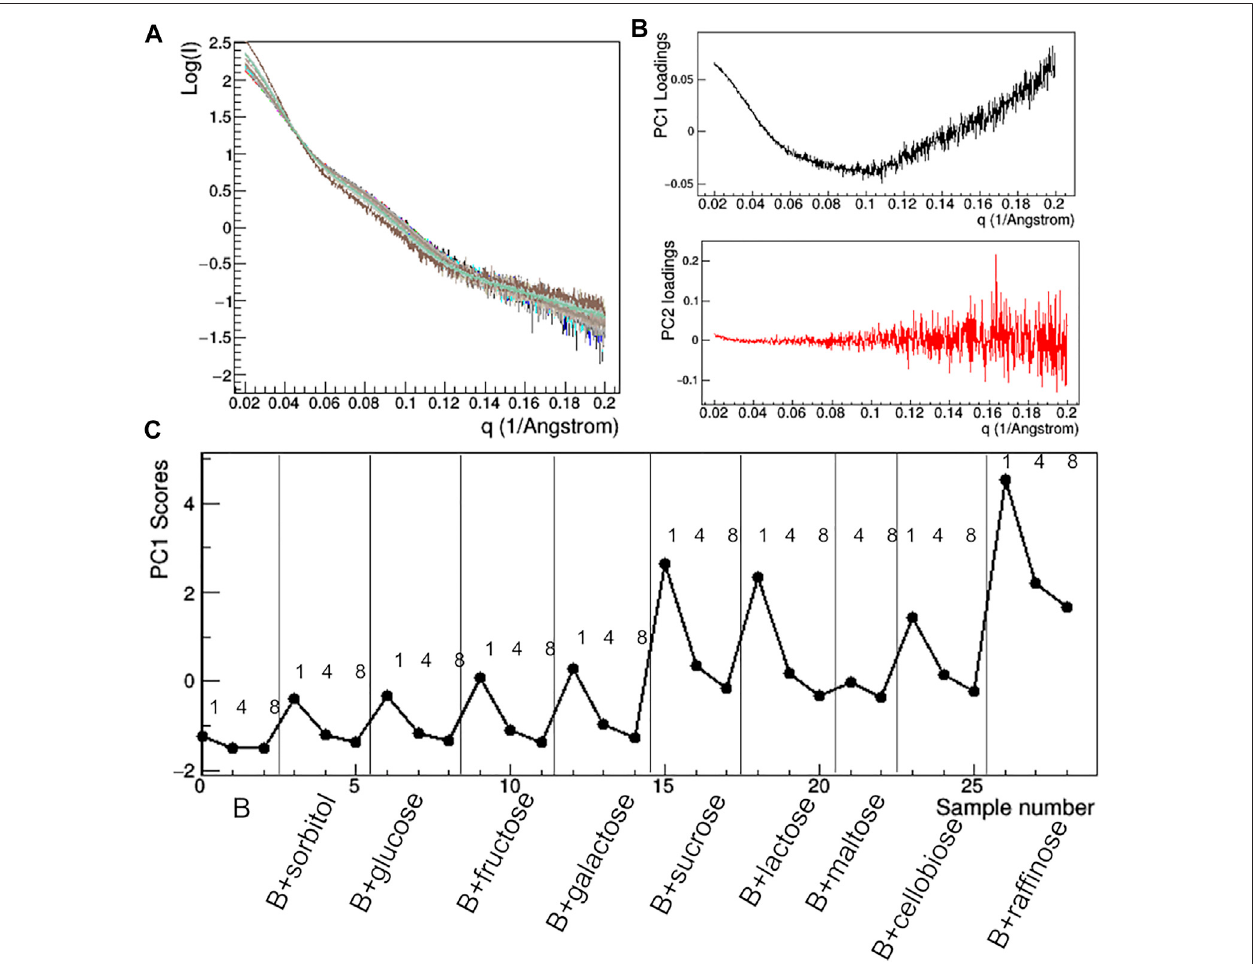
FIGURE 13 | PCA analysis of the raw SAXS data taken for rituximab in solutions containing different sugars. Superposition of the individual SAXS pro fi les, representing the data matrix supplied to PCA (A) ; loadings of the fi rst (PC1) and second (PC2) principal components (B) ; PC1 scores as a function of the dataset considered, with mAb concentration in mg/ml and type of additive reported (C)